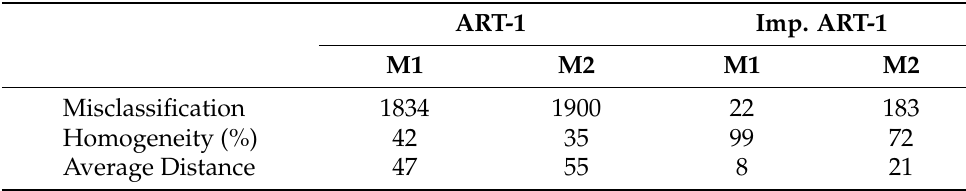
Table 1. Performance analysis between binary conversion method-1 and method-2 considering ART-1 and Improved-ART-1